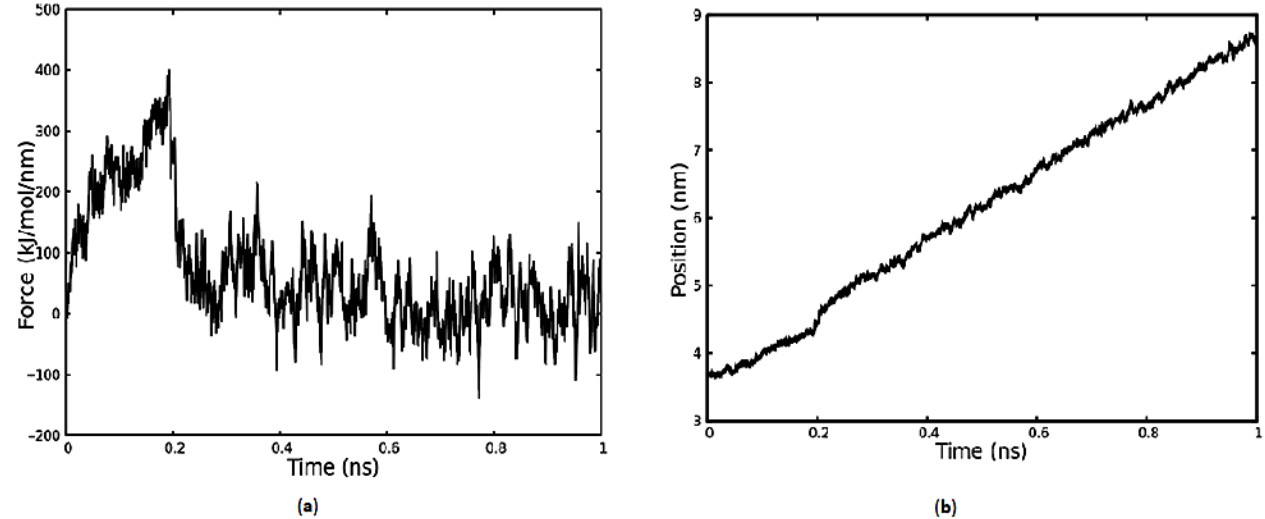
Figure 5. In ( a ), the force that is necessary to pull the KRSR peptide’s center of mass is represented as a function of time. In ( b ), the z coordinate of the peptide’s center of mass is depicted as a function of time. The surface of the TiO 2 slab is between 0 and 3.5 nm.